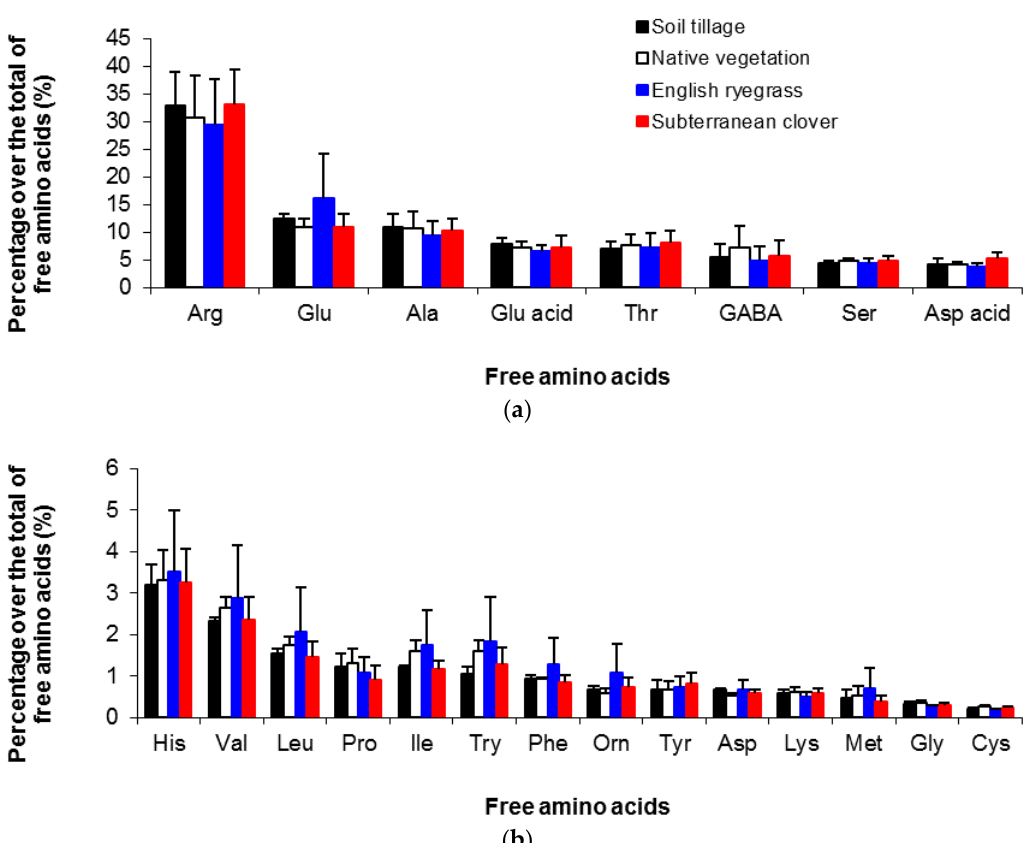
Figure 2. Percentage of each amino acid over the total amino acids in Mencía musts from different soil management systems averaged for three seasons (2012–2014). The upper and lower graphs depict the major ( a ) and minor ( b ) amino acids, respectively. Bars indicate standard errors. Arginine (Arg); glutamine (Glu); alanine (Ala); glutamic acid (Glu acid); threonine (Thr); γ -aminobutyric acid (GABA); serine (Ser); aspartic acid (Asp acid); histidine (His); valine (Val); leucine (Leu); proline (Pro); isoleucine (Ile); tryptophan (Try); phenylalanine (Phe); ornithine (Orn); tyrosine (Tyr); asparragine (Asp); lysine (Lys); methionine (Met); glycine (Gly); cysteine (Cys).